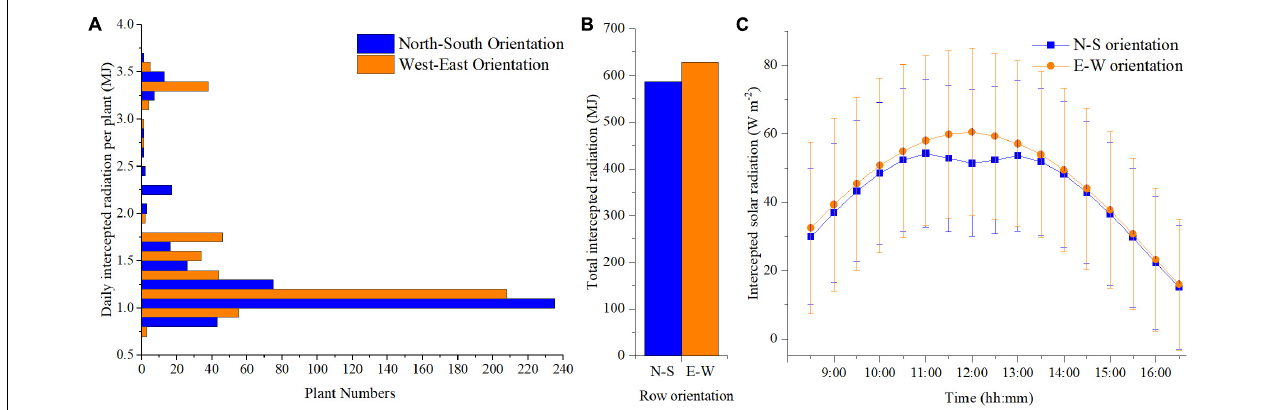
FIGURE 8 | Comparison of the daily total intercepted radiation with corresponding number of plants of N–S orientation and E–W orientation of planting pattern 4 (A) . Comparison of single plant daily accumulated solar radiation of N–S orientation and E–W Orientation of planting pattern 4 (incrementing row) (B) . Comparison of plant average solar radiation intensity of N–S orientation and E–W Orientation of planting pattern 4 (incrementing row) (C) .